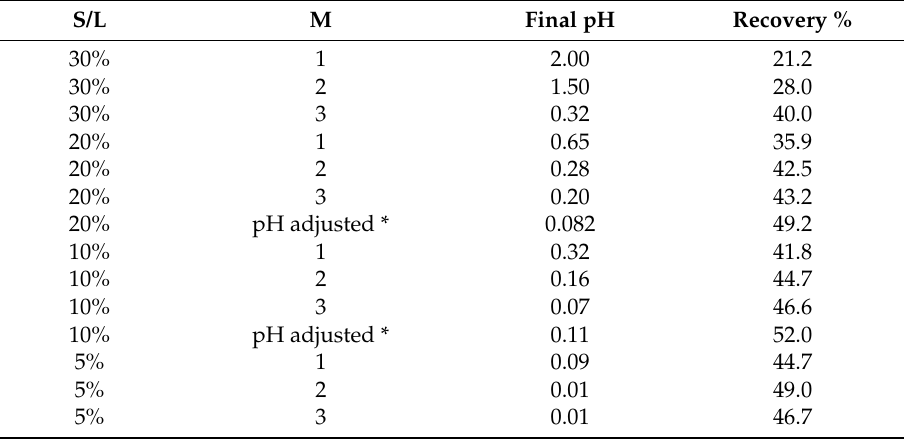
Table 2. pH values of the leachate for different S/L values and acid molarities ( t = 60 min).